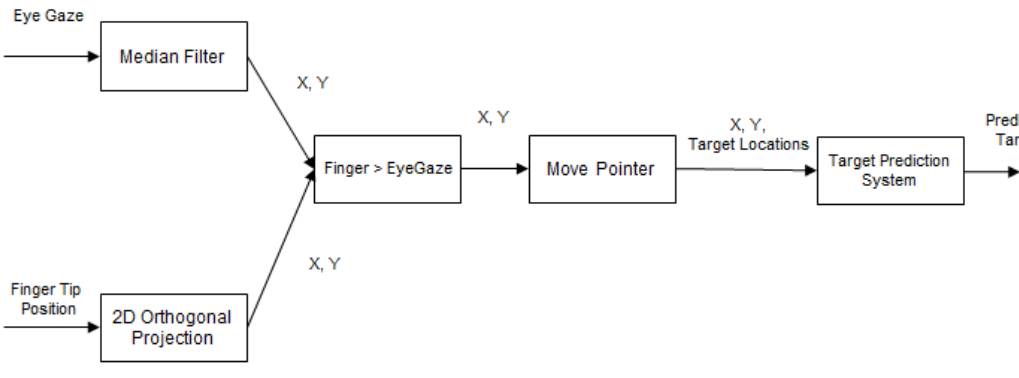
Figure 7. State chart diagram of Eye Gaze–Finger tracking combined system.